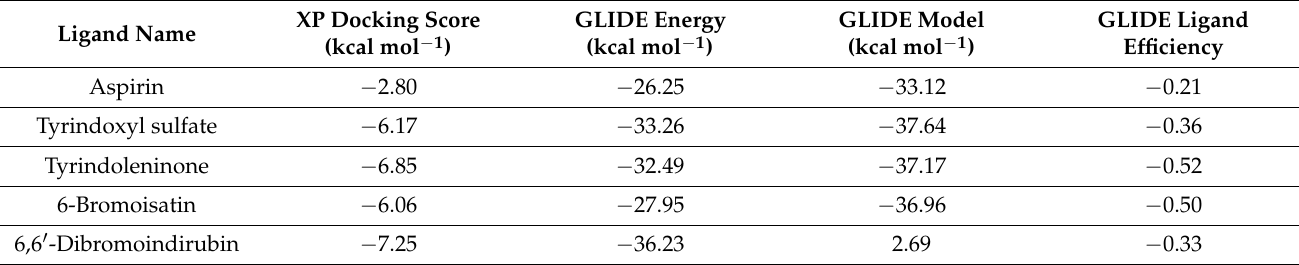
Figure 3. 3D interaction maps (distances Å) of Dicathais orbita brominated indole derivatives and standard aspirin showing the crystallographic ligand with a COX-2 active binding site; ( a ) aspirin, ( b ) tyrindoxyl sulfate, ( c ) tyrindoleninone, ( d ) 6-bromoisatin, and ( e ) 6,6’-dibromoindirubin. Table 1. Summary of molecular docking analysis and XP-score results from Schrodinger (Maestro v11.6) for COX-1 (PDB ID: 3N8X), the reference molecule aspirin, and four Dicathais orbita